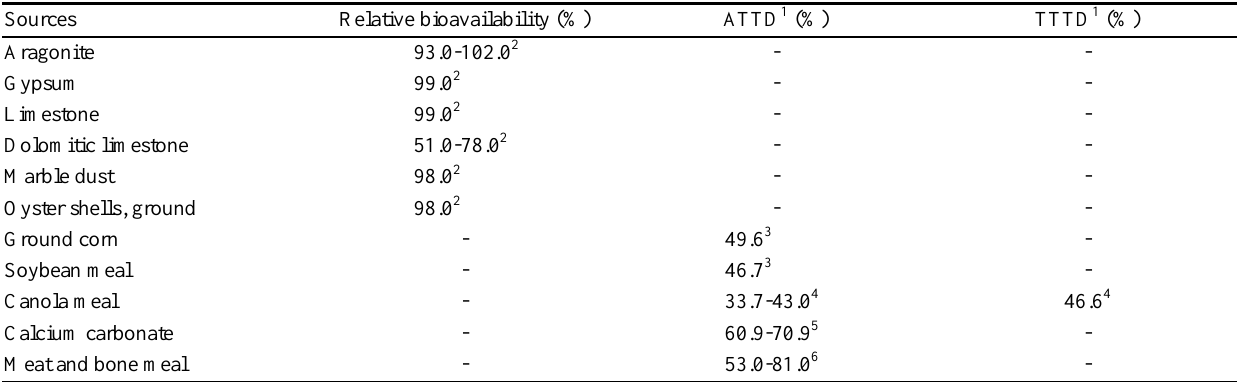
Table 4. Availability and digestibility of calcium